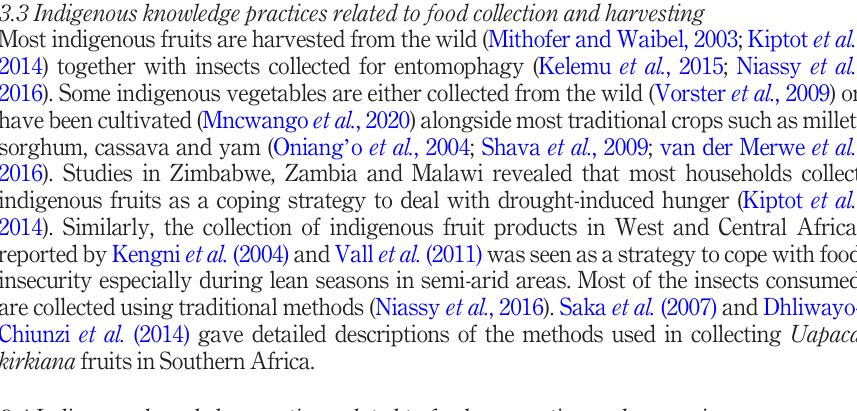
Figure 2. Mapping IK-based food security studies in